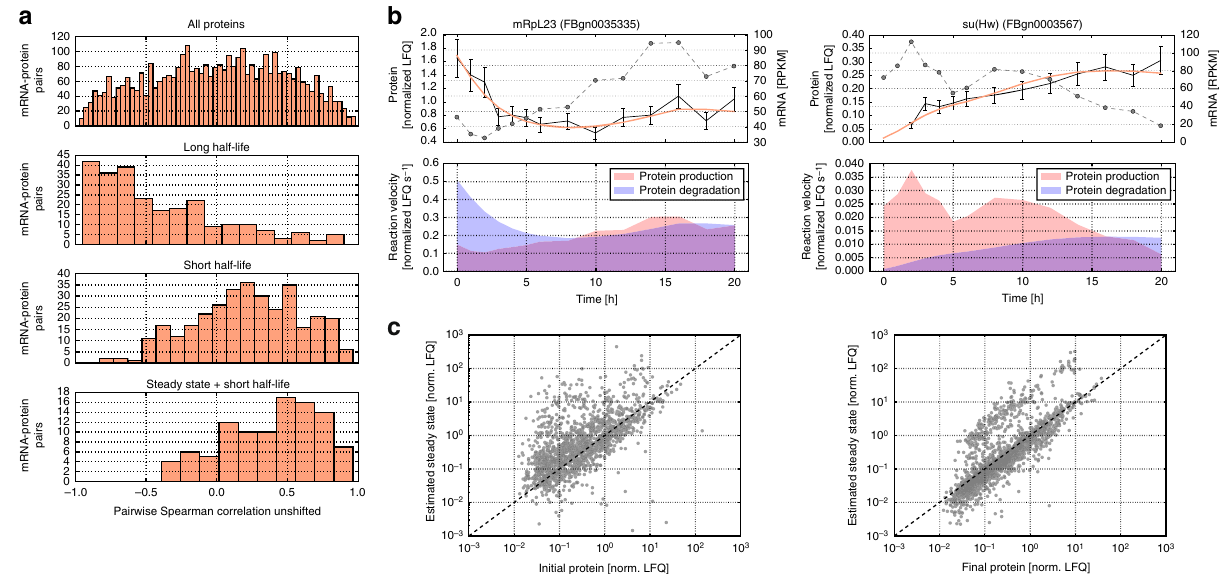
Fig. 4 Kinetic models explain lack of mRNA − protein correlation. a The correlation of mRNA and protein time courses depends on protein dynamics and initial expression levels. Histograms for the distribution of Spearman correlations for all 3761 mRNA − protein pairs (top panel, n = 3761), proteins with long half-life (second panel, n = 260), proteins with short half-life (third panel, n = 331) and proteins with short half-life close to their estimated steady-state at the onset of embryogenesis (bottom panel, n = 101). See main text for details. b Examples of genes with inverse mRNA and protein dynamics. Left: For mRpL23 (FBgn0035335), mRNA level (dashed line) increased while protein levels (black line) decreased. Error bars represent standard deviation of protein according to the chosen linear error model. Model fi t is shown as colored line. The lower panel shows the simulated velocities of protein production and degradation, which are initially unbalanced. Right: Conversely, for su(Hw) (FBgn0003567) the protein production velocity initially exceeds that of degradation, protein amount (black line) increased, while mRNA level decreases. c Protein levels early in development tend to deviate from the model- predicted protein steady-state. Measured protein levels for mRNA − proteins pairs classi fi ed into the production model ( n = 2027) are plotted against estimated protein steady-states. Steady-state estimates were derived from the fi tted model parameters as well as given mRNA concentrations at 0 h (left panel, Pearson correlation ρ = 0.61) and 20 h (right panel, Pearson correlation ρ = 0.79) using the equation α / λ * mRNA[ t ] ( α : production rate;